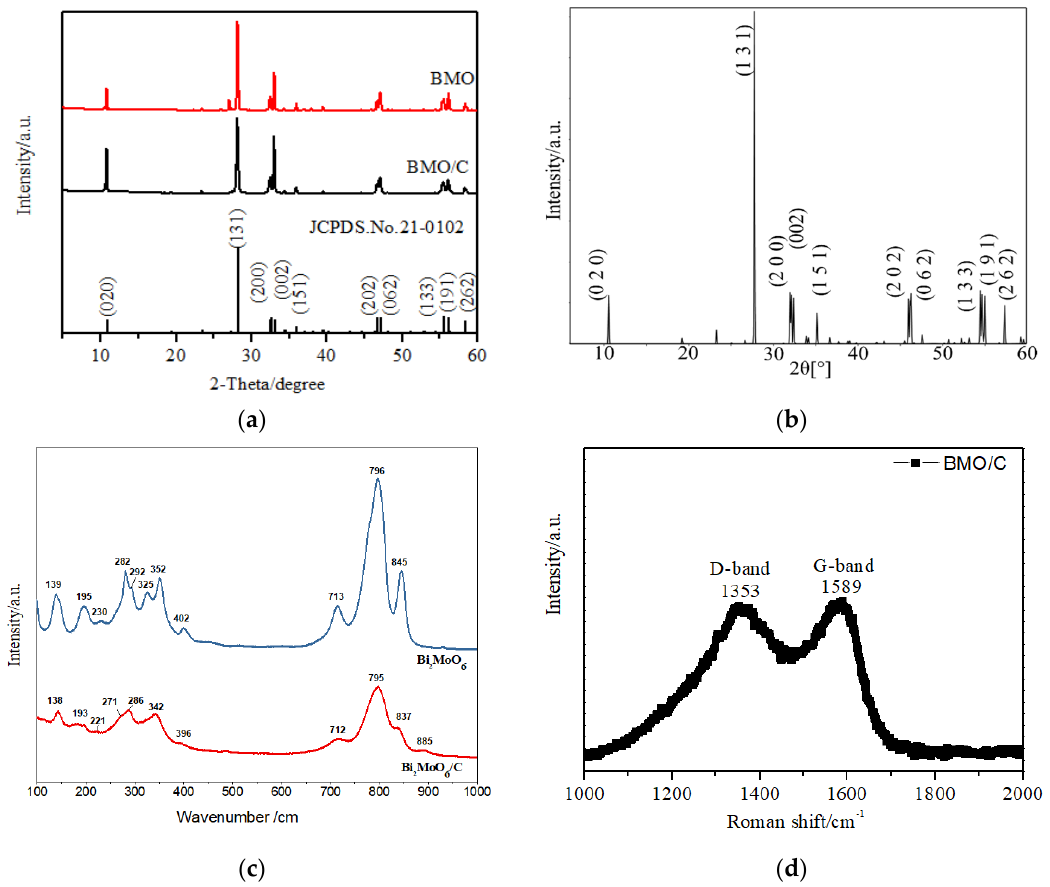
Figure 3. ( a ) XRD patterns of BMO/C, BMO and standard card, and ( b ) DFT simulated XRD pattern for BMO ( c ) Raman spectrum of BMO and BMO/C samples in the wavelength range of 100–1000 cm − 1 ; ( d ) Raman spectrum of the as- synthesized BMO/C in the wavelength range of 1000–2000 cm − 1 .